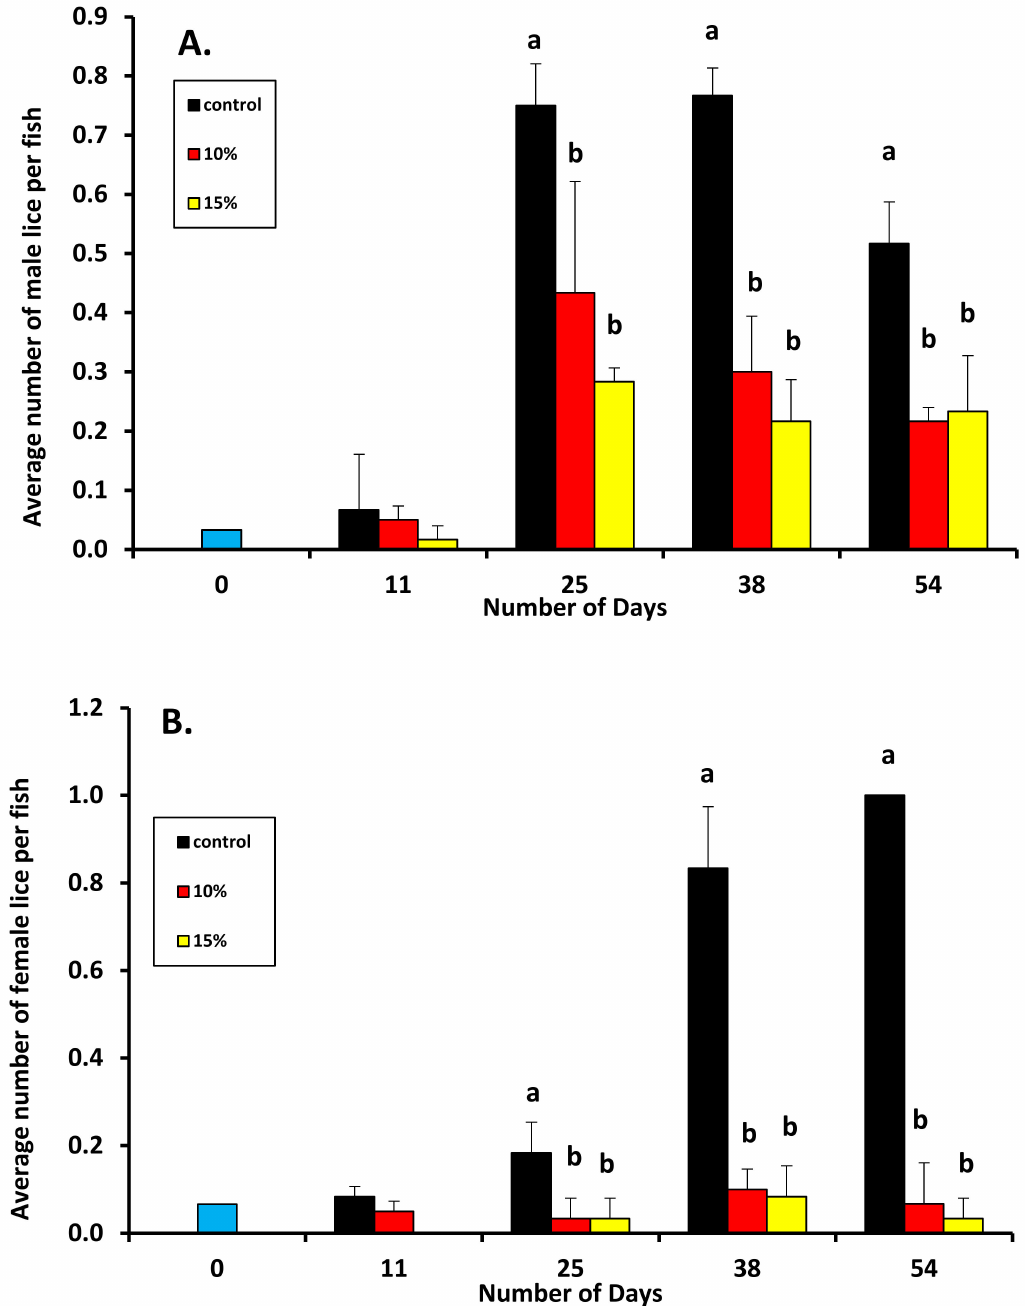
Figure 1. Total average number of adult male ( A ) and adult female ( B ) L. salmonis on Atlantic salmon reared with two different densities of lumpfish. Control group was not reared with lumpfish. Values are presented as means ± S.D. Mean values that do not share a letter are significantly different according to ANOVA and Tukey’s multiple range test ( p < 0.05). Figure modified from